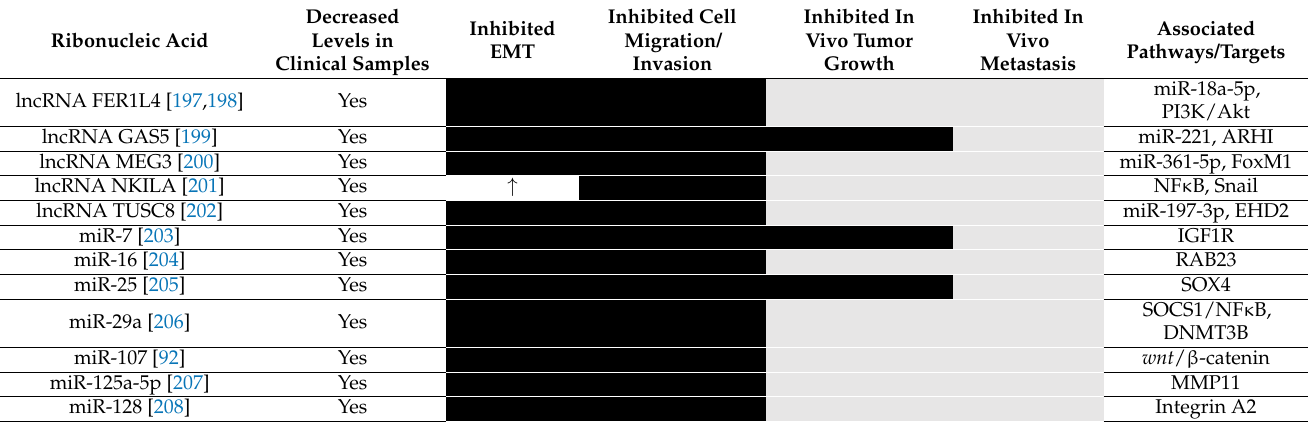
Table 4. Effects of poorly expressed non-coding ribonucleic Table 2. Effects of poorly expressed proteins in OS. Table 2. Effects of poorly expressed proteins in OS.